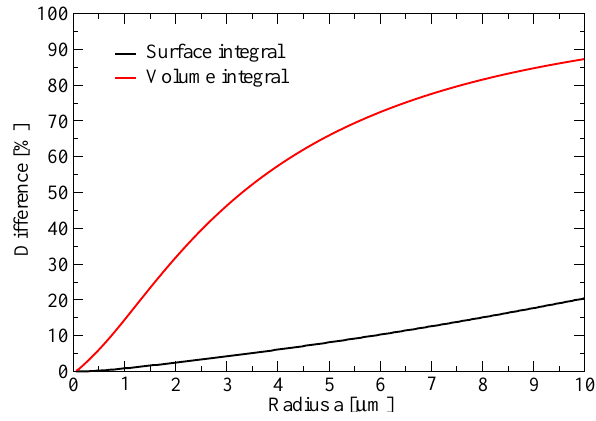
Fig. 8. Change of particle size with humidity as derived by H¨anel Fig. A8. Change of particle size with humidity as derived by H¨anel (1976), and measurements over Paris (see Randriamiarisoa et al. (1976), and measurements over Paris (see Randriamiarisoa et al. (2006) during times of increasing and decreasing humidity). For (2006) during times of increasing and decreasing humidity). For the PM 10 retrieval, the parameterization as indicated by the solid the PM 10 retrieval, the parameterization as indicated by the solid red line, is used. red line, is